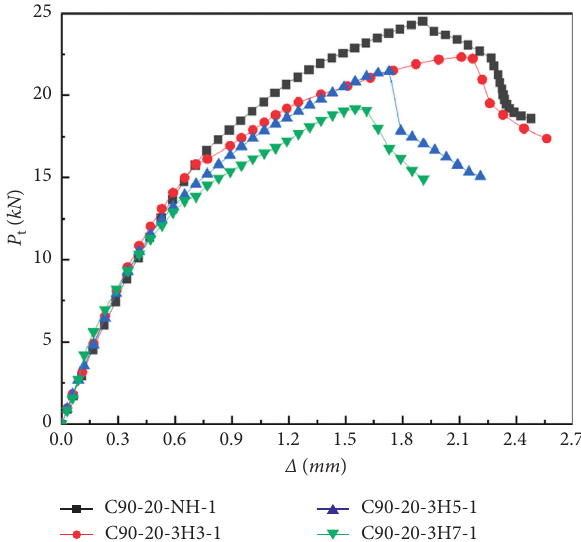
Figure 15: Load versus axial shorten displacement curves for section C90-20.